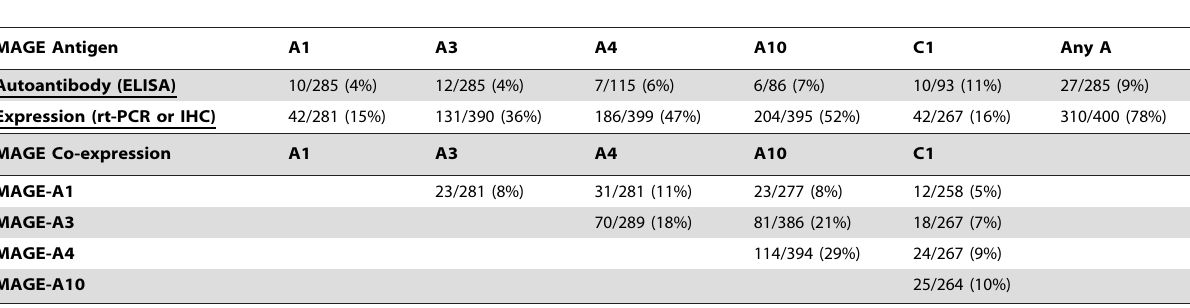
Table 2. Serum antibody and co-expression status for MAGE antigens in ovarian cancer.